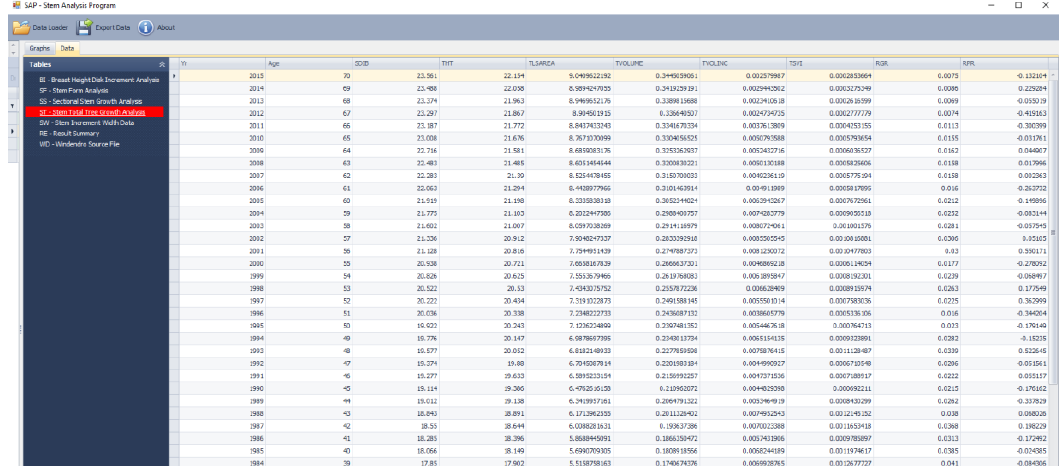
Figure 2. Screenshot of the output data file/table list under the “Data” tool bar for the example tree, with the partial ST110022 file output displayed, which details the annual volumetric growth responses from 1984 to 2015 for the entire tree, inclusive of the 2nd thinning treatment in 1997 (n., the rapid increases in specific volume increment (TSVI) and relative growth rate (RGR) for approximately 7 years post-treatment (1997–2004)).